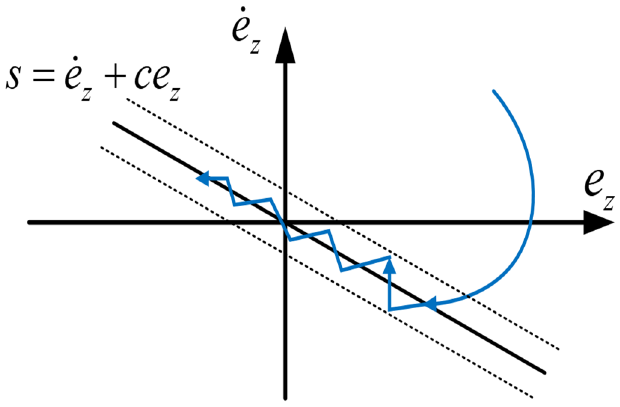
Figure 7. State motion process of real system.